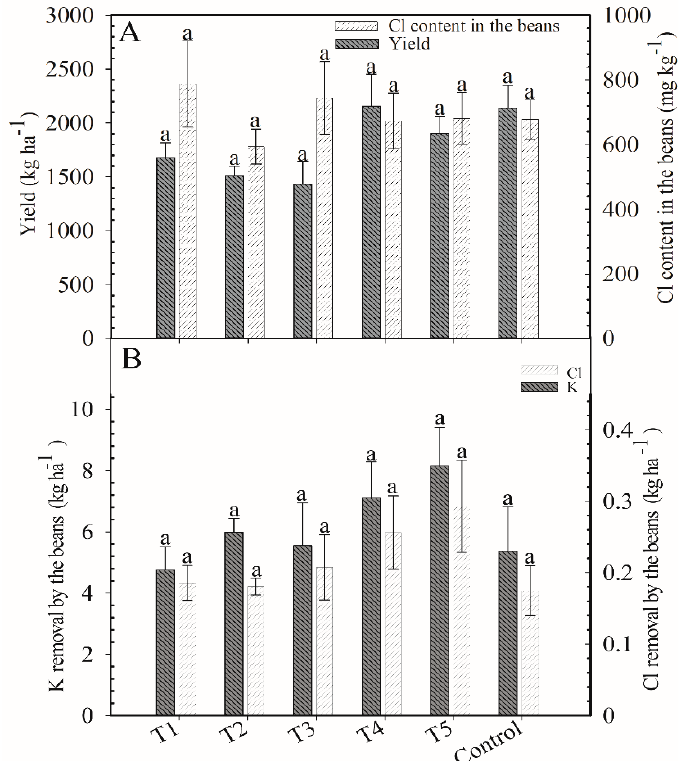
Figure 3. Yield of coffee plants and Cl content in the beans at cherry stage ( A ) and K and Cl removal by the beans ( B ) after application of blends of KCl e K 2 SO 4 as cover fertilization. Harvest of 2018/2019. Means followed by the same letter in the column do not differ according to Tukey’s test ( p < 0.05). Vertical bars indicate the standard error of the mean ( n = 4). T1: 100% KCl; T2: 75% KCl + 25% K 2 SO 4 ; T3: 50% KCl + 50% K 2 SO 4 ; T4: 25% KCl + 75% K 2 SO 4 ; T5: 100% K 2 SO 4 ; control did not receive K 2 O.